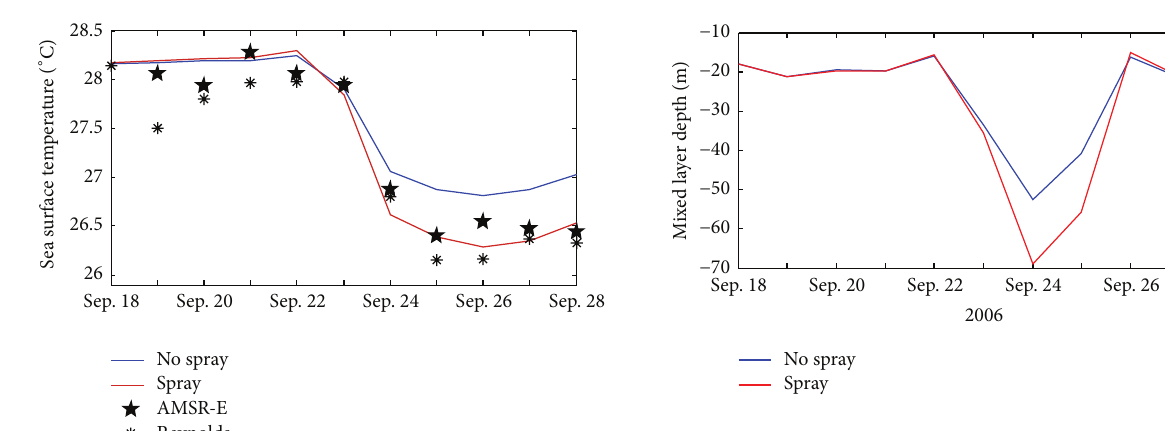
Figure 6: Time series (daily) of the mixed layer depth from simulations with (Test 2) and without (Test 1) sea spray effect at the fixed station. The red (blue) line is the mixed layer depth with (without) sea spray